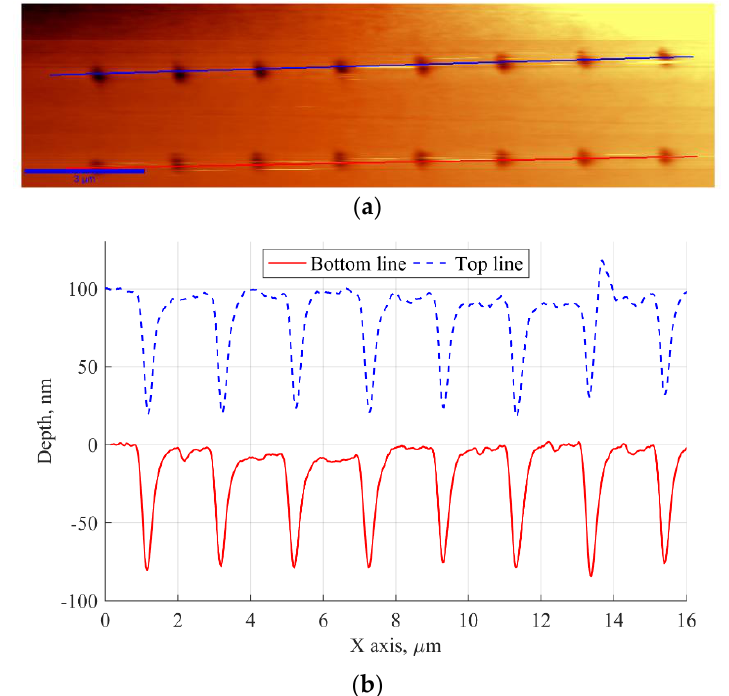
Figure 5. ( a ) AFM scan topography of the optimized structure and ( b ) cross sectional profile of the holes along the marked lines of the optimized pattern at constant laser beam power.